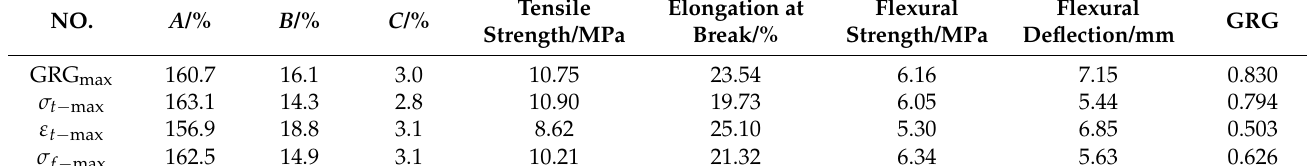
Table 8. Response optimal ratio experimental comparison table.